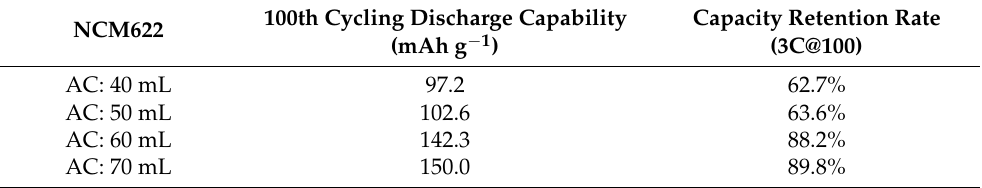
Table 5. Cycling capability of NCM622 different ammonia content.